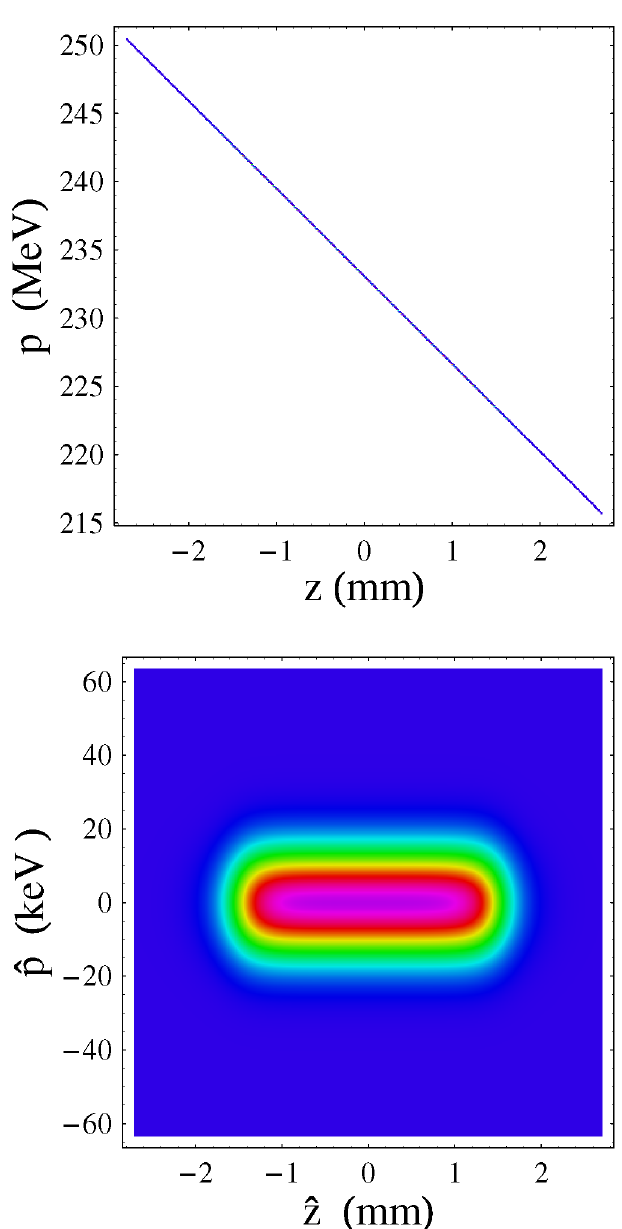
FIG. 1. (Color) Support of the beam density function in phase space at the entrance of a bunch compressor in the (cid:2) z; p (cid:4) coordinates (top picture). The beam density of the same beam is plotted in the (cid:2) ^ z; ^ p (cid:4) coordinates (bottom picture) where the beam linear chirp has been subtracted. The phase space in the bottom picture can be more efficiently gridded by a Cartesian